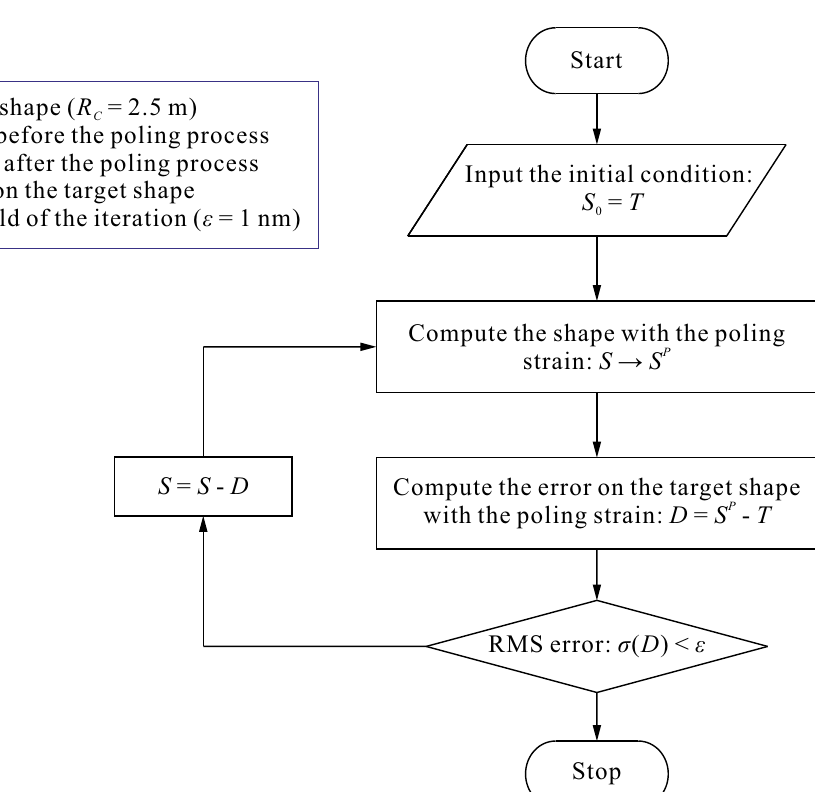
Figure 11. Flowchart of the iteration algorithm for solving the inverse problem to reconstruct the initial shape before poling.